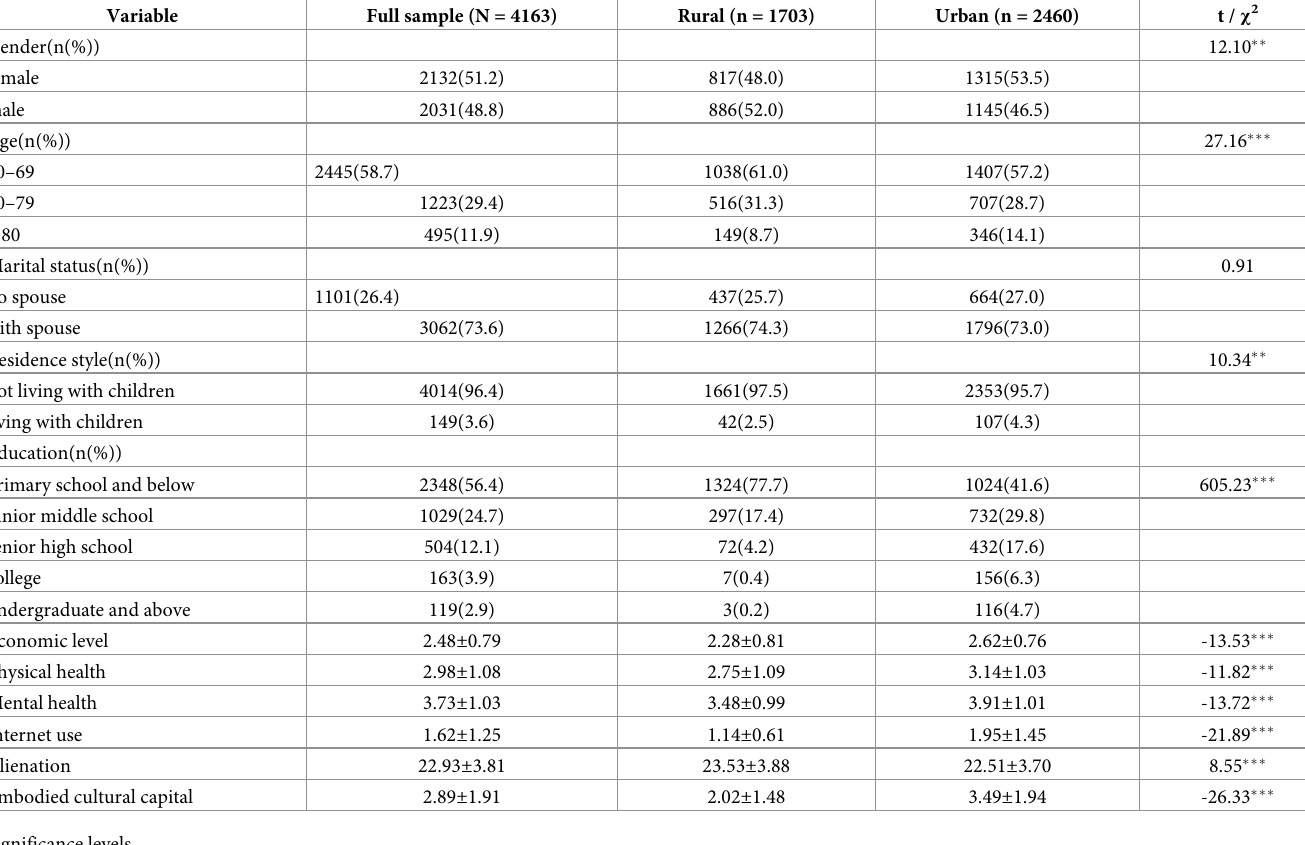
Table 2. Descriptive statistics of sample